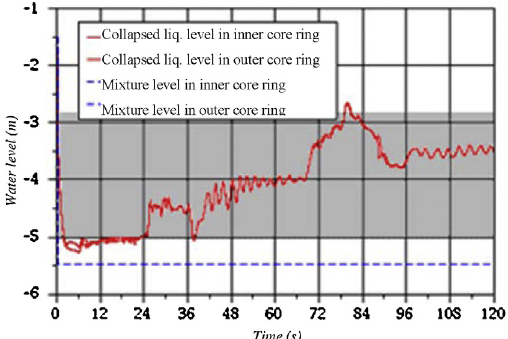
Fig. 14. Water level in the vessel. Grey area represents core zone.